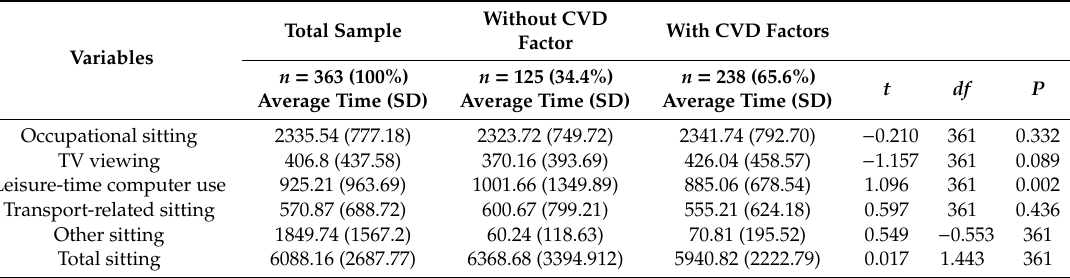
Table 3. The mean of sedentary behavior patterns by with and without CVD